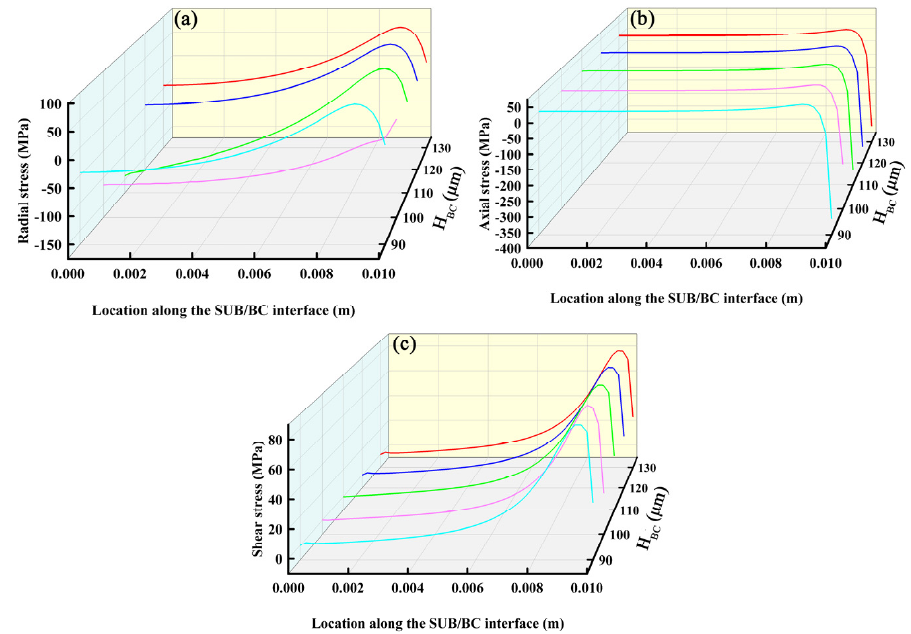
Figure 6. Stress distributions along SUB/BC interface: ( a ) radial stress; ( b ) axial stress and ( c ) shear stress.